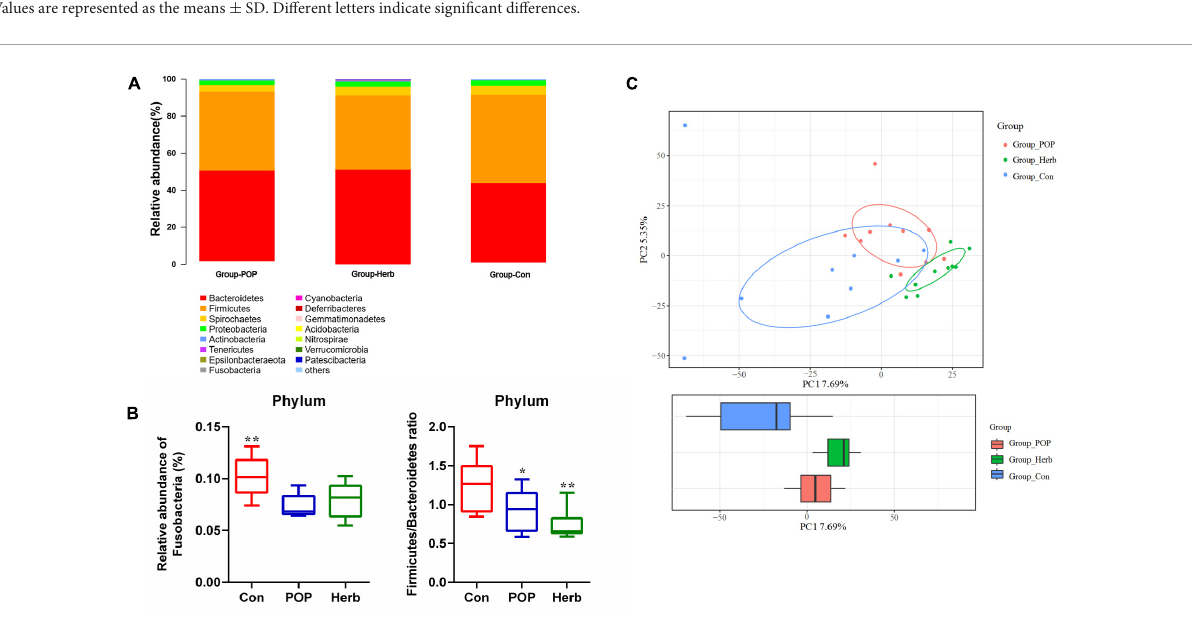
FIGURE4 (A,B) Changes in the structure of fecal microbiota at the phylum level in the Con, POP, and herb groups. (C) PCA plots of all samples. * and ** indicate statistically significant differences ( P < 0.05 and P < 0.01,